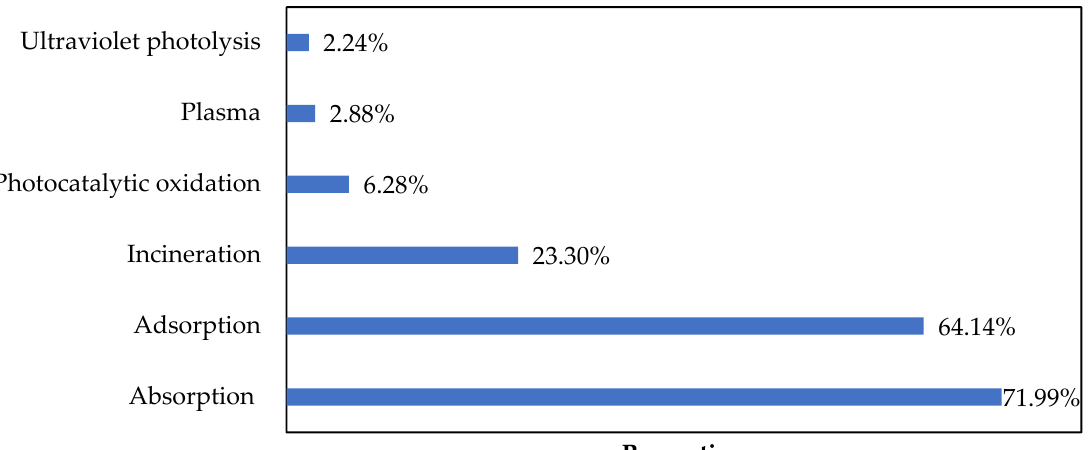
Figure 2. Proportion of VOC treatment usage in pesticide manufacturing industry facilities.